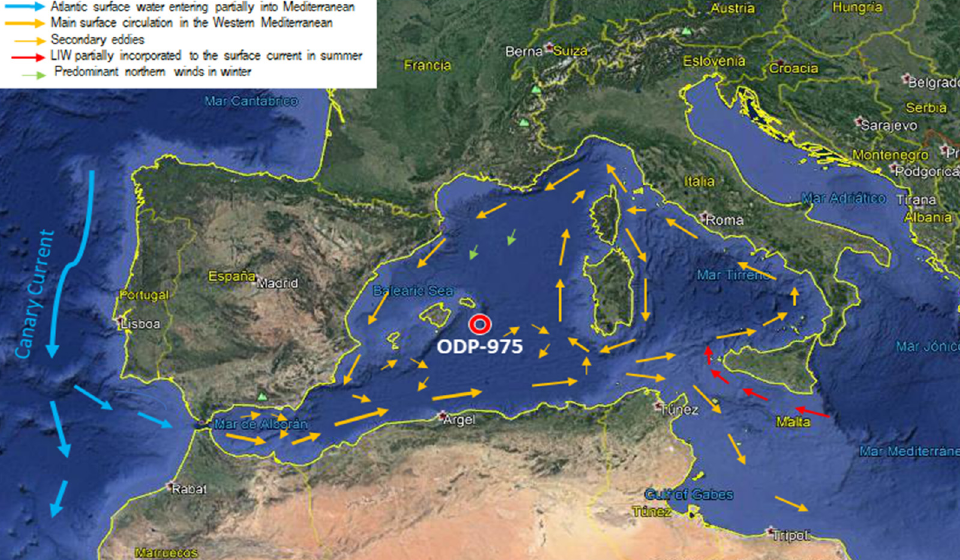
Figure 1. Predominant surface currents in the Western Mediterranean Sea and location of the Ocean Drilling Program (ODP)-site 975. LIW: Levantine intermediate water. Geographic basis from image Landsat, Google Earth.